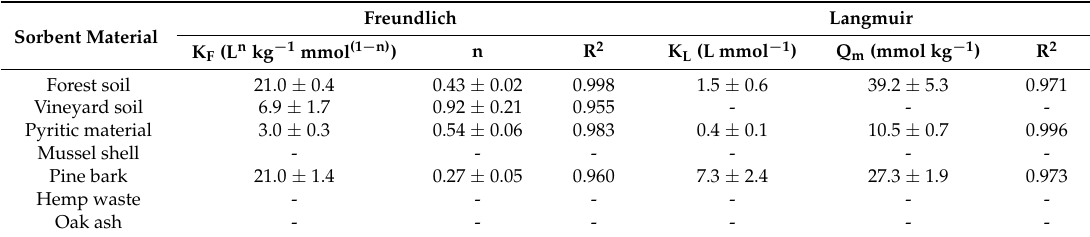
Freundlich and Langmuir constants and R 2 (coefficients of determination) values corresponding to Cd sorption on the soils and by-products studied. -: error values too high for